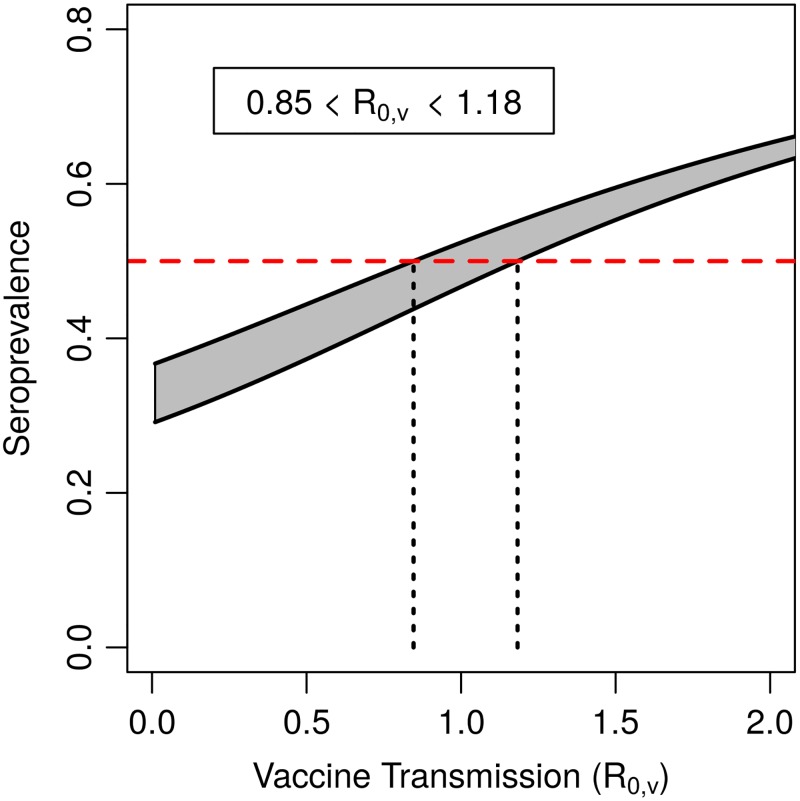
Predicted seroprevalence with vaccine transmission in US raccoon rabies campaigns.The filled region indicates the range in seroprevalence that would be achieved with a transmissible vaccine, given the range in seroprevalence that was achieved by USDA campaigns with a nontransmissible vaccine. The red dashed line indicates the coverage that is recommended to protect a raccoon population from rabies. The dashed black lines indicate the range of R0,v that satisfies the herd immunity threshold. Other parameters: d = 0.416 yr−1, δv = 12 yr−1.